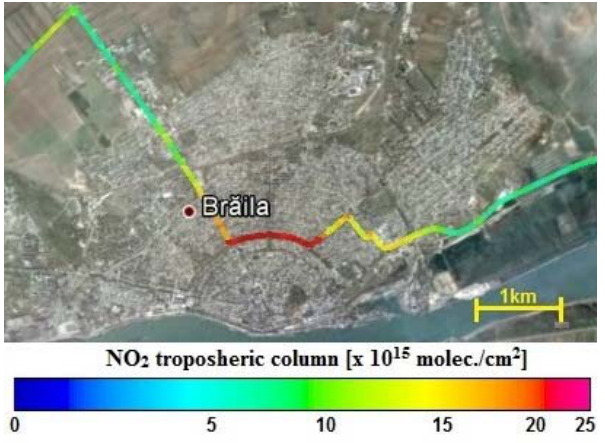
Figure 12. The NO “city center effect” in Braila town figured with mobile zenith-sky 2 DOAS measurement on 28 July